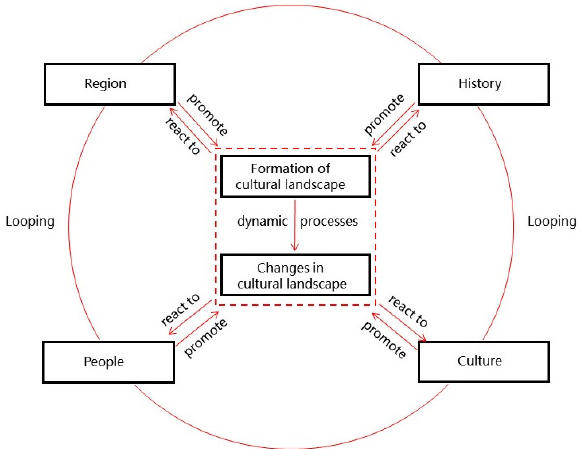
Figure 2. Four different spatial dynamics promote the formation of and change in cultural landscapes (source: Drawn by the author).